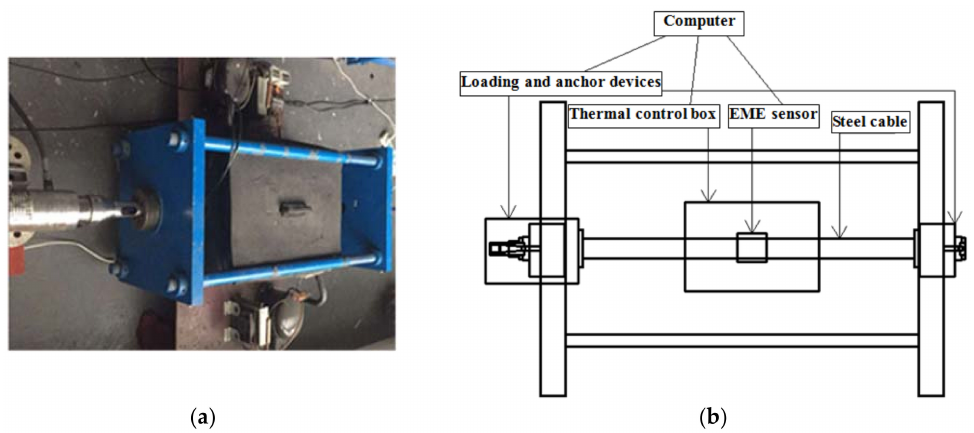
Figure 1. Experimental setup: ( a ) Photo; ( b ) Schematic diagram.